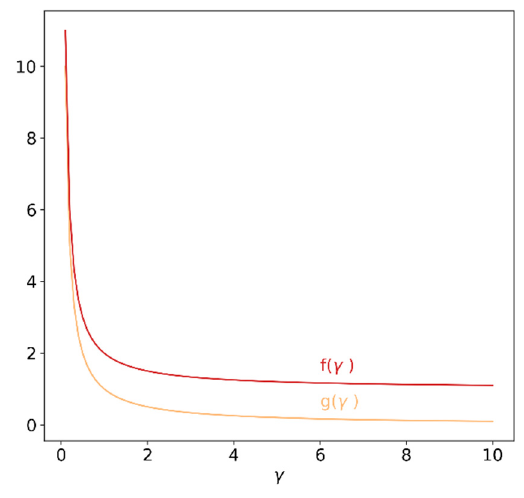
Figure 3. Diagram of f ( γ ) and g ( γ ) functions.